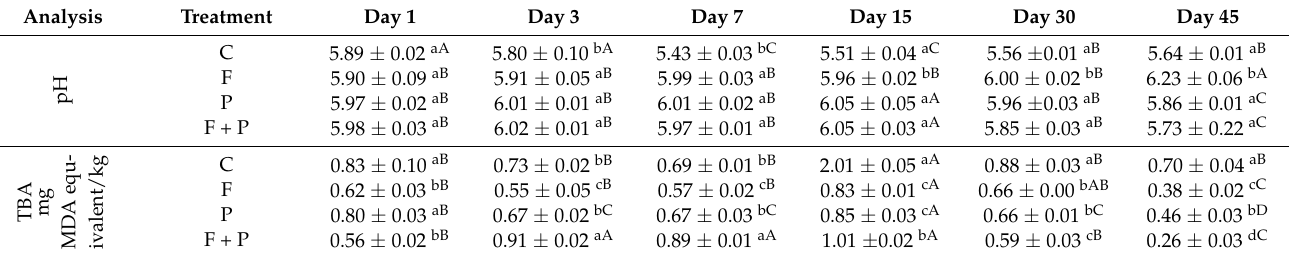
Table 1. pH, thiobarbituric acid values of control, frozen and pressurized (350 MPa, 10 min., 10 ◦ C) after frozen and pressurized without frozen samples during the storage (F samples at − 21 ◦ C; other samples at +4 ◦